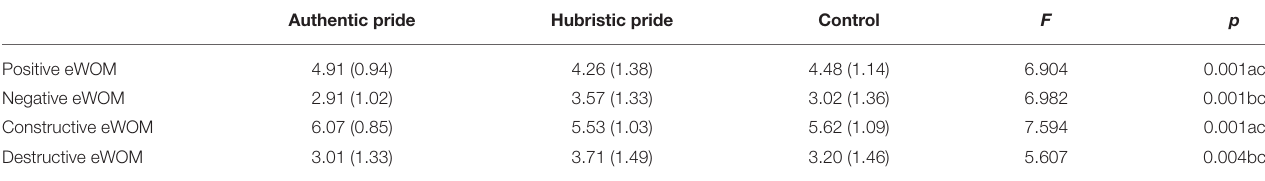
TABLE 1 | Means between the pride conditions: study